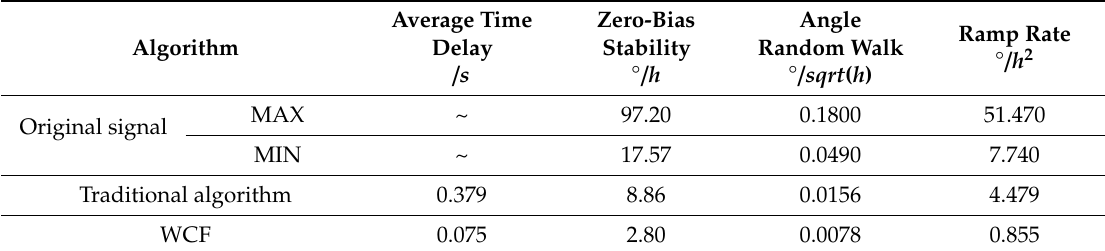
Table 5. Online processing results of different algorithms.